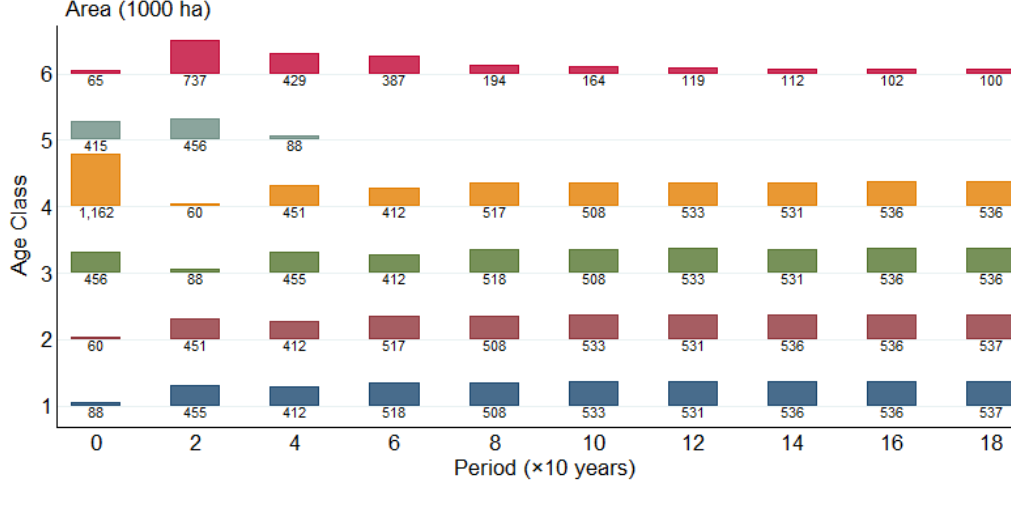
Figure 2. Changes in forest area by age class.